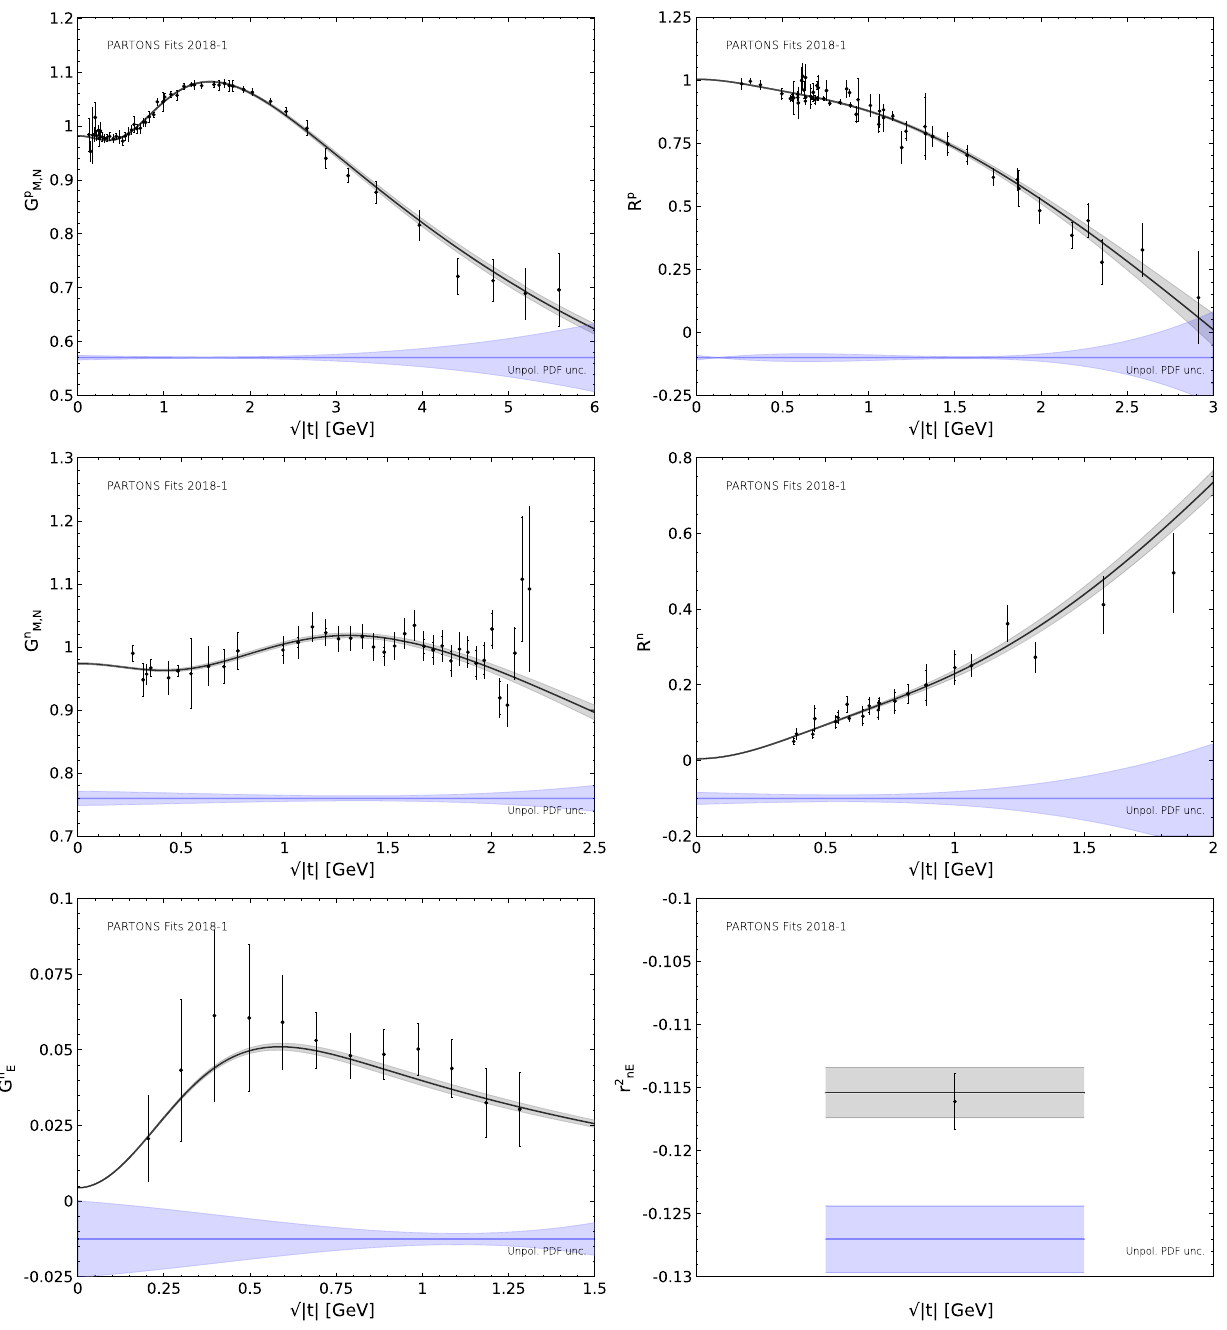
Fig. 4 ElasticForm Factor data listedin Table 1 and fitted according to the text. The gray bands indicate 68% confidence level for uncertainties coming from EFF data. The corresponding bands for unpolarized PDFs are indicated by the labels. For data points provided with systematic